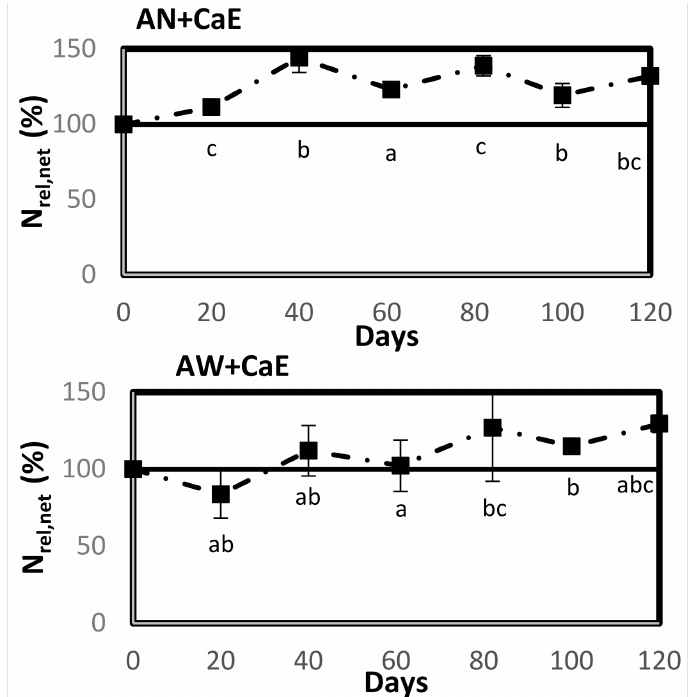
Figure 1. Net N release (N rel,net (%)) relative to the N input of added materials in a 120-day incubation experiment. The value plotted at t = 0 for treatments indicates the percentage of mineral N in the applied material and is presented as a straight line through the experimental duration. Net N mineralization is indicated by the values plotted above this line, and net N immobilization is indicated by values below the line. Standard deviation is indicated by the error bars (n = 3). Lower cases indicate significant differences between treatments at each sampling point (Tukey’s test ( p <